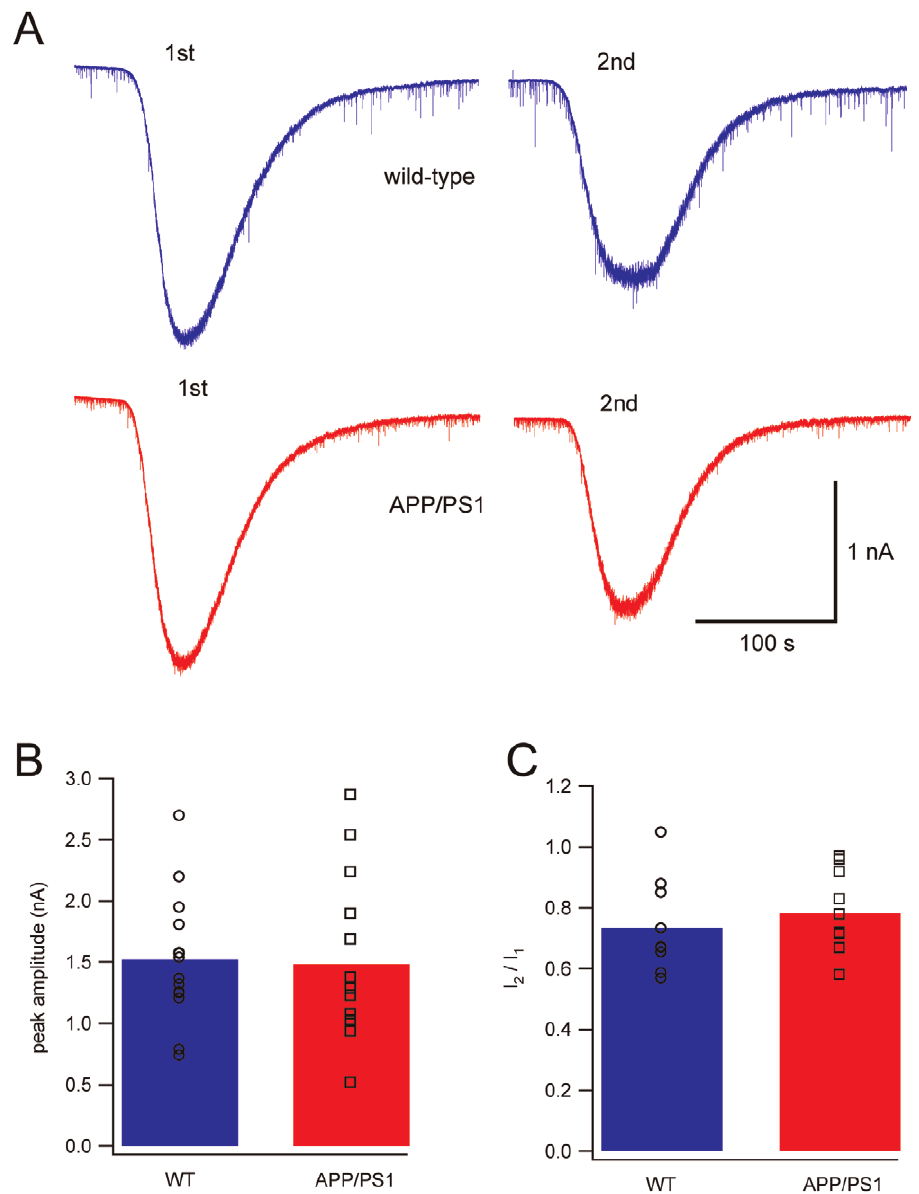
Figure 7. Responses to applications of muscimol. ( A ) Representative currents evoked by two applications of muscimol (0.5 m M), ten minutes apart, in wild-type (blue) and APP/PS1 cells (red). ( B ) Mean amplitude of peak currents in wild-type and APP/PS1 cells evoked by the first application of muscimol (P . 0.05, Student’s t-test). ( C ) Ratio of the second current peak amplitude relative to the first one for both groups (P . 0.05, Student’s t-